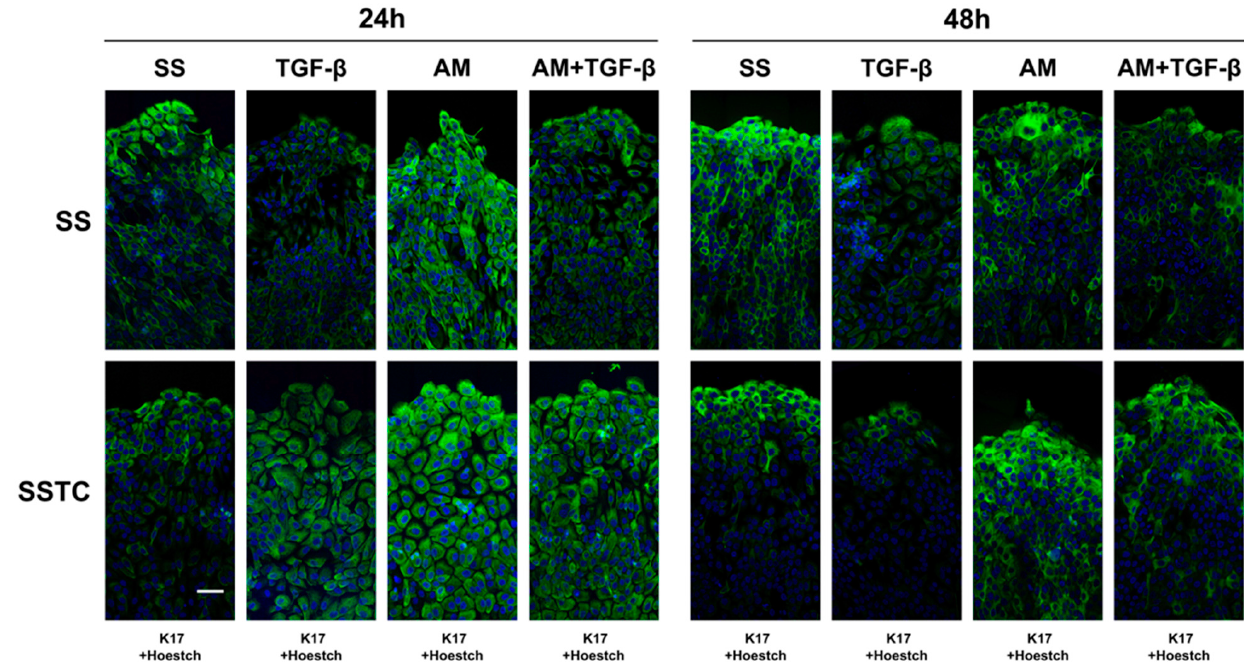
Figure 8. Amniotic membrane treatment reinstates functional activation of HaCaT cells persistently exposed to TGF- β . The ability of keratinocytes to develop proper activation responses upon mono- layer disruption was evidenced via keratin-17 (green) immune labeling. Nuclei are colored blue. Representative images taken at the indicated times for each condition and treatment of at least three independent experiments are shown. The scale bar equals 50 µm.